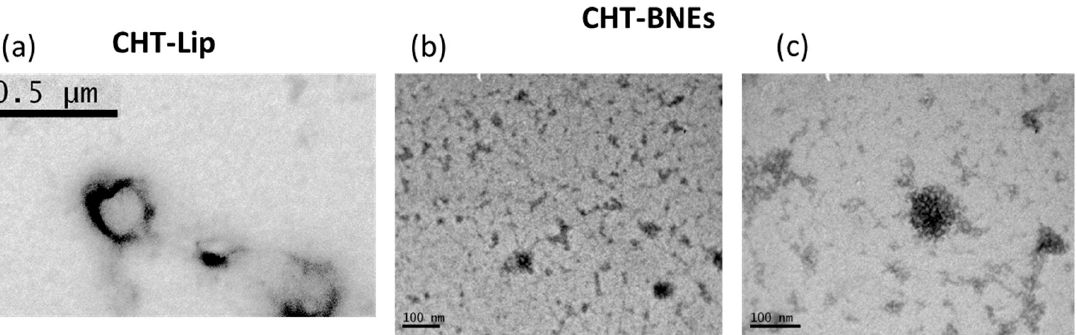
Figure 7. TEM micrographs of the CHT-coated ( a ) BNN27-loaded LIPs (PC/PG LIPs coated with 0.1% MMW CHT), ( b ) BNEs with 8%-oil phase, and ( c ) BNE with 10%-oil phase.